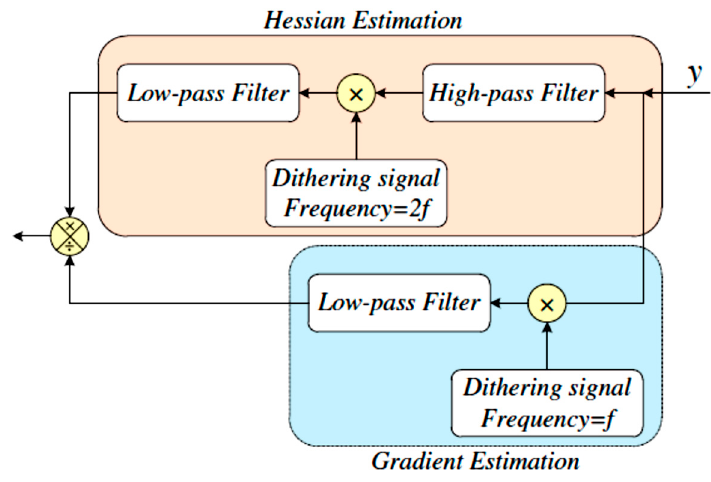
Figure 3. Classical ESC estimator [31] (Reprint with permission [31]; 2013 Elsevier Ltd.).